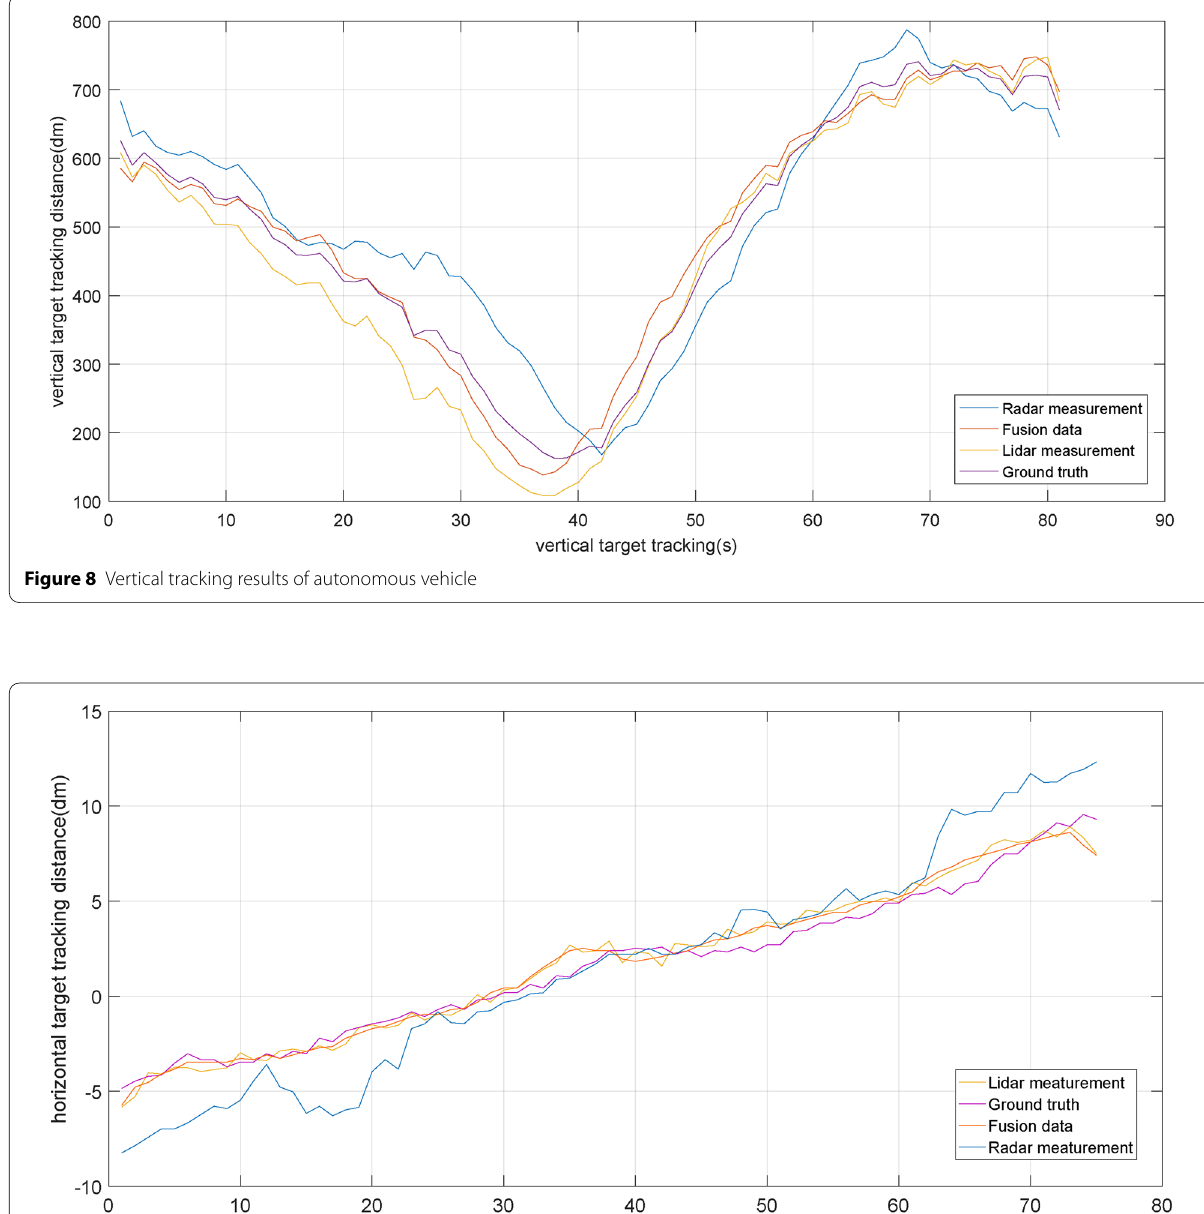
velocity information is displayed in real time on the tar- get tracked. The horizontal and vertical tracking experiments in all six scenarios recorded about 80 ‒ 90 s of video. Our fusion method runs in real-time and is lightweight. After the tracking target is determined on the road, our self- driving car will drive within the range of 10 ‒ 80 m behind